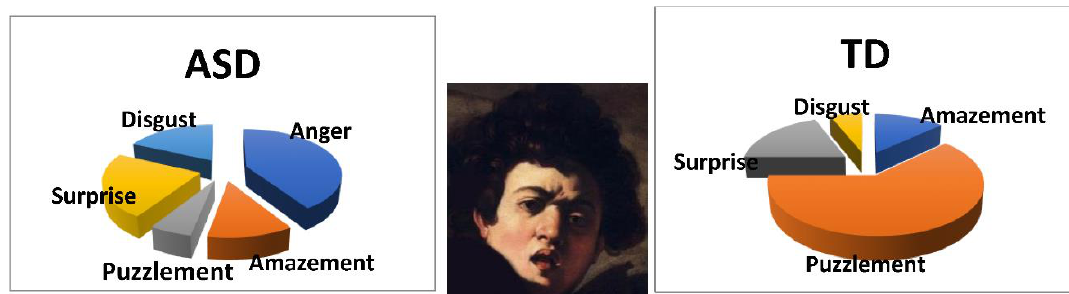
Figure 8. Different emotions attributed to image 4a (in the middle) by ASDs ( left ) and TDs ( right ).